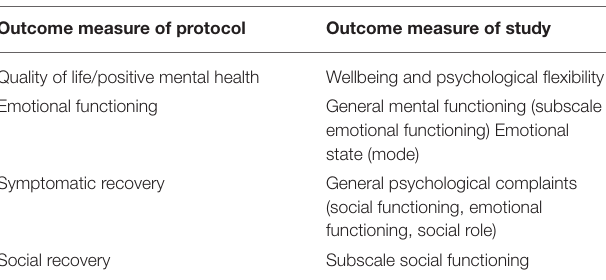
TABLE 3 | Outcome